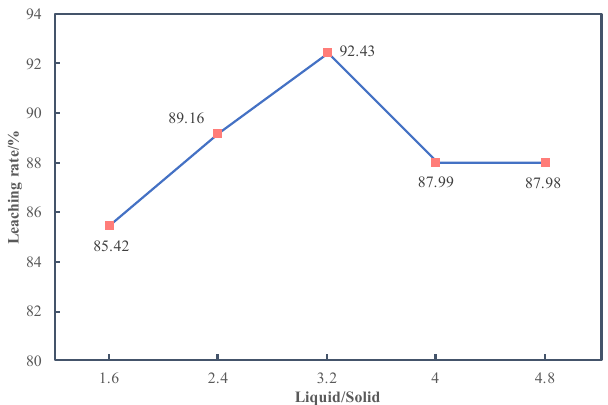
Figure 6. Effect of liquid/solid ratio on leaching rate of titanium.